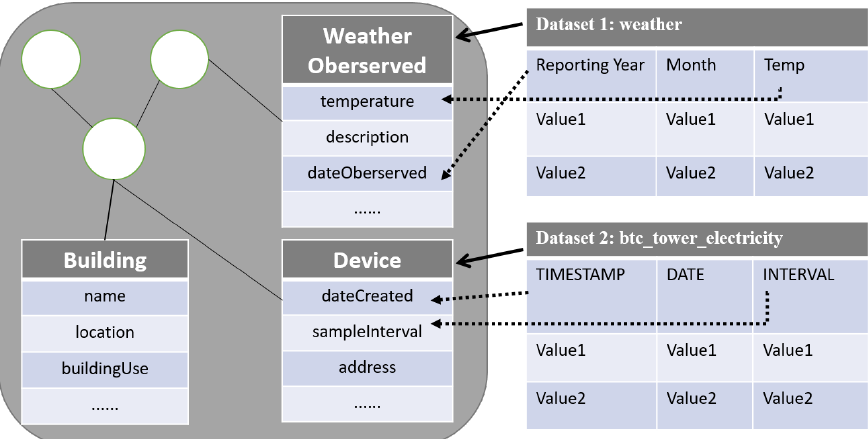
Figure 1. Data model and raw data